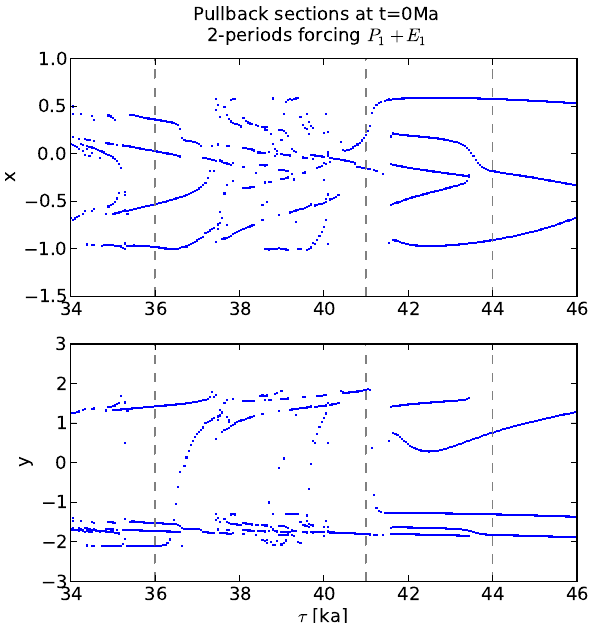
Fig. 10. (Top) pullback attractors of the forced van der Pol oscil- lator ( β = 0 . 7, α = 30, γ = 0 . 6 with 2-period forcing) as in Fig. 8, for τ = 41ka. They are reproduced on the graphs below (very thin lines), overlain by (middle) one pullback attractor with same pa- rameters but τ = 40ka, and (bottom) one stochastic realisation of the stochastic van der Pol oscillator with τ =